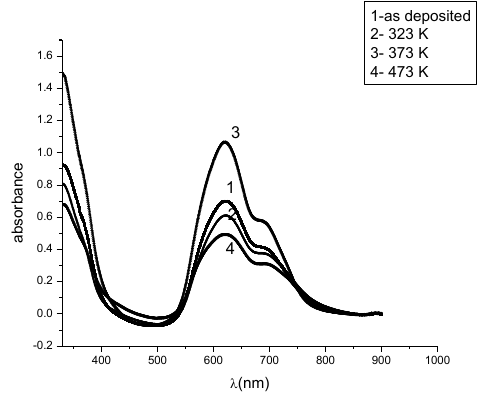
Figure 2 Absorption spectra of H